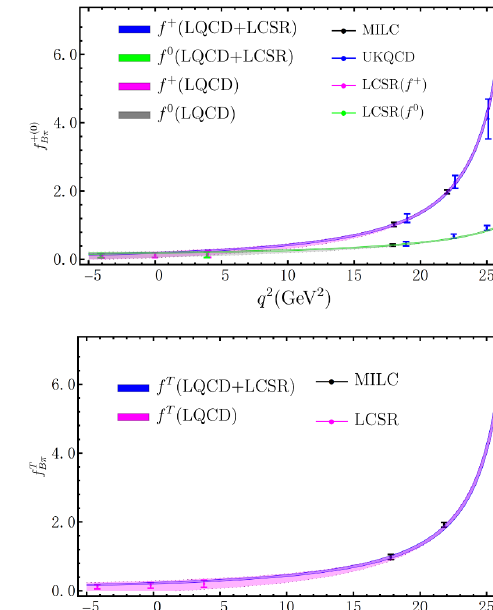
JHEP03(2023)140